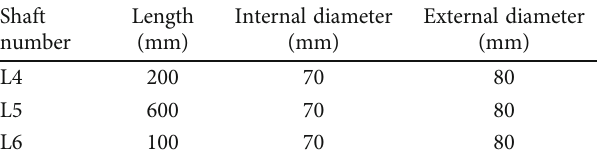
Table 2: Dimensions of shafts in the high-pressure rotor.